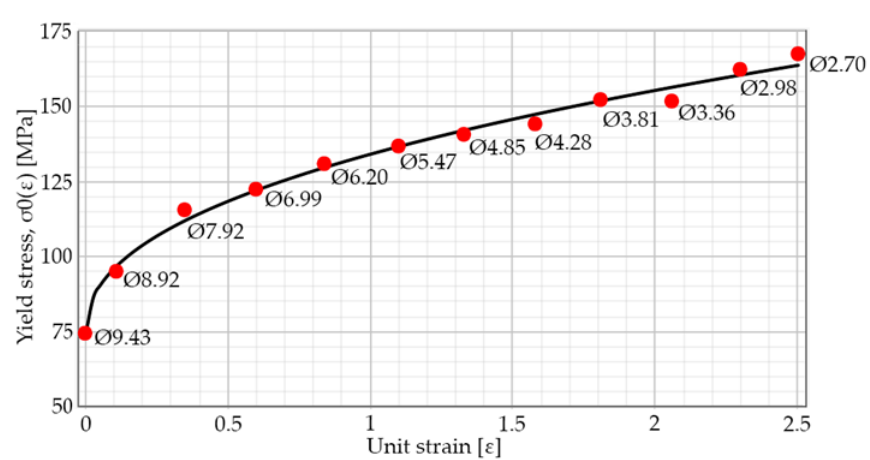
Figure 5. Curve ‐ law of hardening by cold deformation of EN AW ‐ 1370 wiredrawn aluminium. Figure 5. Curve-law of hardening by cold deformation of EN AW-1370 wiredrawn aluminium. Figure 5. Curve-law of hardening by cold deformation of EN AW-1370 wiredrawn aluminium. 𝜎 (cid:3026)(cid:4666)(cid:3036)(cid:4667) (cid:3404) 74.2 (cid:3397) 59.804 ∙ (cid:3435)𝜀 (cid:4666)(cid:3036)(cid:4667) (cid:3439) (cid:2868).(cid:2872)(cid:2872) (5) 0.44 𝜎 = 74.2 + 59.804 ∙ (𝜀 ) 𝑌(𝑖) (𝑖)